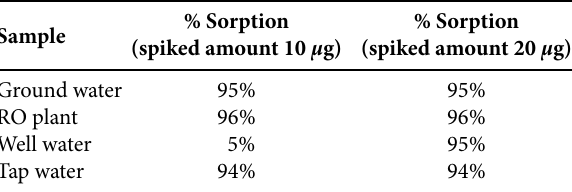
Table 6. Cr(VI) removal from water samples % Sorption % Sample